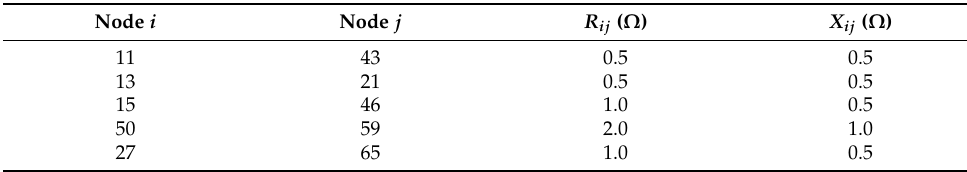
Table 7. Parameters of the 69 nodes meshed test